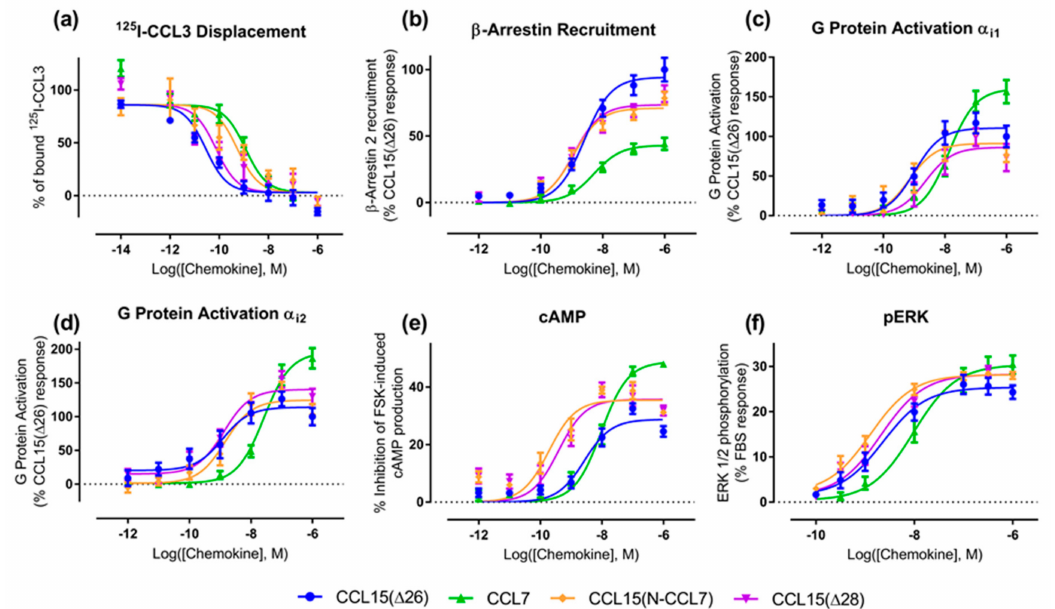
Figure 3. CCR1 binding and activation by chemokine N-terminal variants. Each graph shows the concentration-response data for a di ff erent signal readout, as described in Materials and Methods: ( a ) binding, ( b ) β Arr2 recruitment, ( c ) G protein activation using G α i1 , ( d ) G protein activation using G α i2 , ( e ) inhibition of forskolin-induced cAMP production, and ( f ) ERK1 / 2 phosphorylation. Data points represent means ± SEM of at least three independent experiments performed in duplicate.